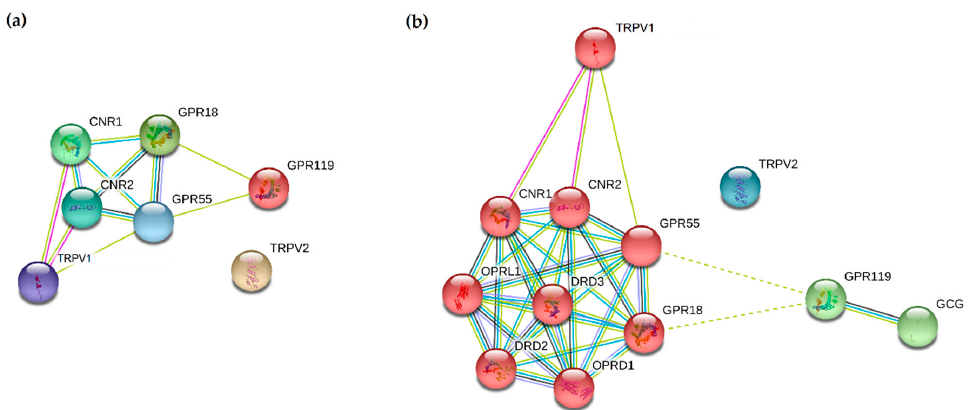
Figure 1. STRING interaction analysis of cannabinoid receptors. ( a ) Direct STRING analysis network was built based on high confidence (0.7) evidence from experimental interaction data (pink), co-expression (black), gene neighbourhood (green) and co-occurrence (blue) data, curated databases (light blue), protein homology (purple), and predictive and knowledge text mining (light green); ( b ) The network was extended to 5 primary-interaction shell genes to explore their indirect interactions and clustering (PPI enrichment p -value: 2.39 × 10 − 12 ) using the intersection of 12 genes present on all analysed platforms. Red nodes— CNR1/CNR2 cluster, green nodes—GPR119 cluster, blue nodes—TRPV2cluster. NodesarelabelledwithHumanGeneNomenclature Committee (HGNC) gene symbols: CNR1 —Cannabinoid receptor 1 gene, CNR2 —Cannabinoid